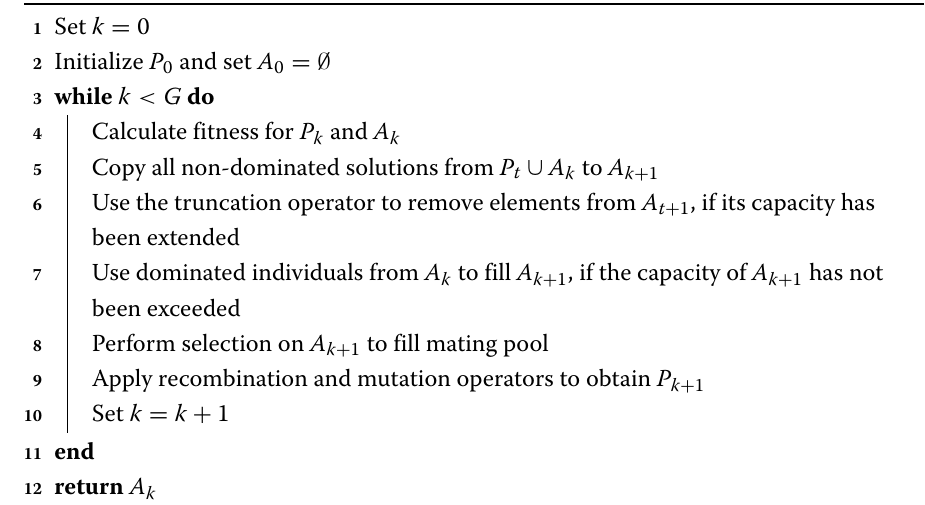
Algorithm 2: SPEA 2 (Zitzler et al.